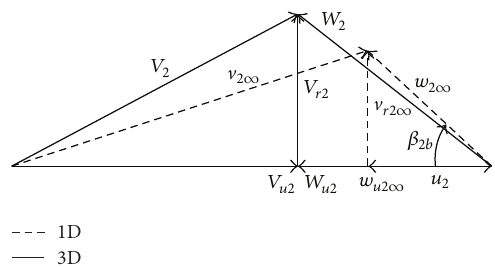
Figure 3: Velocity triangle at impeller discharge for estimate of slip